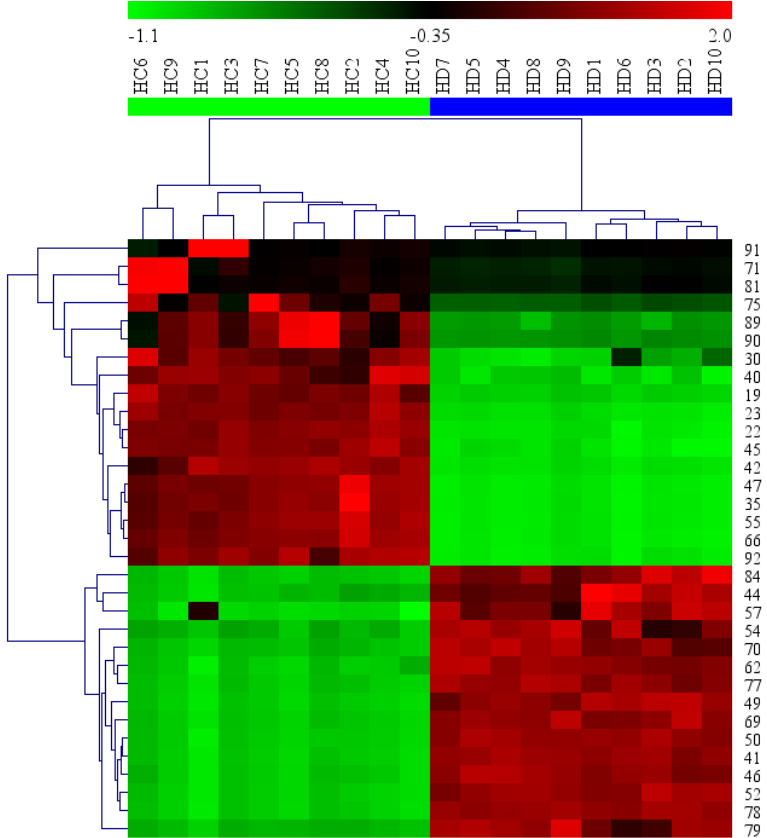
Figure 7. Heatmap visualizing the intensities of potential biomarkers.